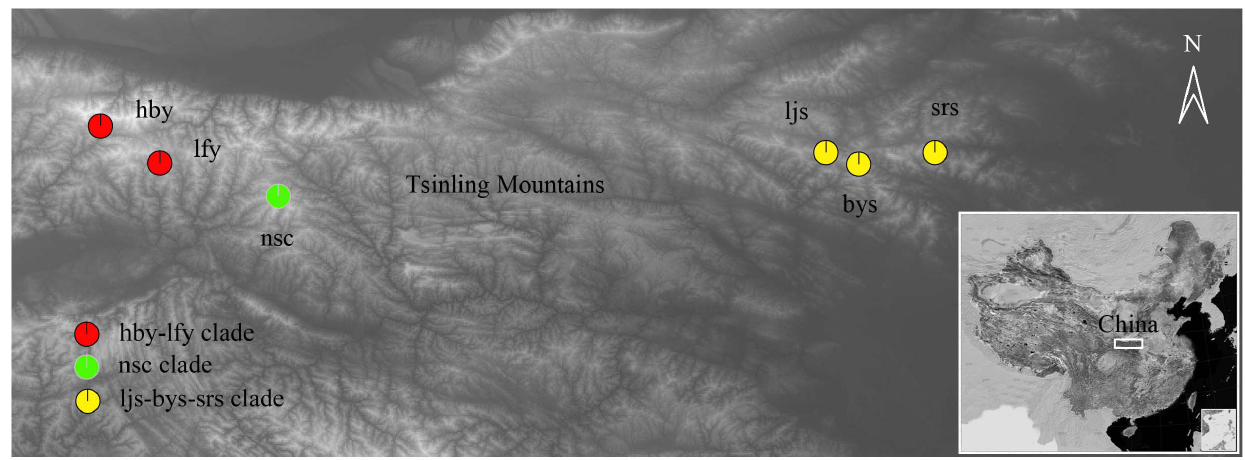
Figure 1. Locations of sampled populations and geographical distribution of S . ningshanensis clades on the Tsinling Mountains. Nsc is also the type locality of S. ningshanensis .